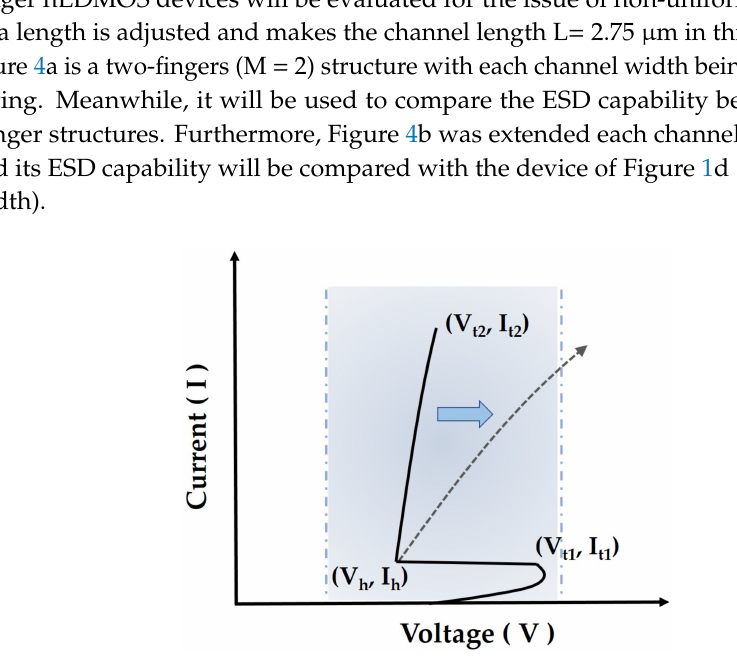
Figure 3. Voltage-current characteristic curves of an ESD protection device.